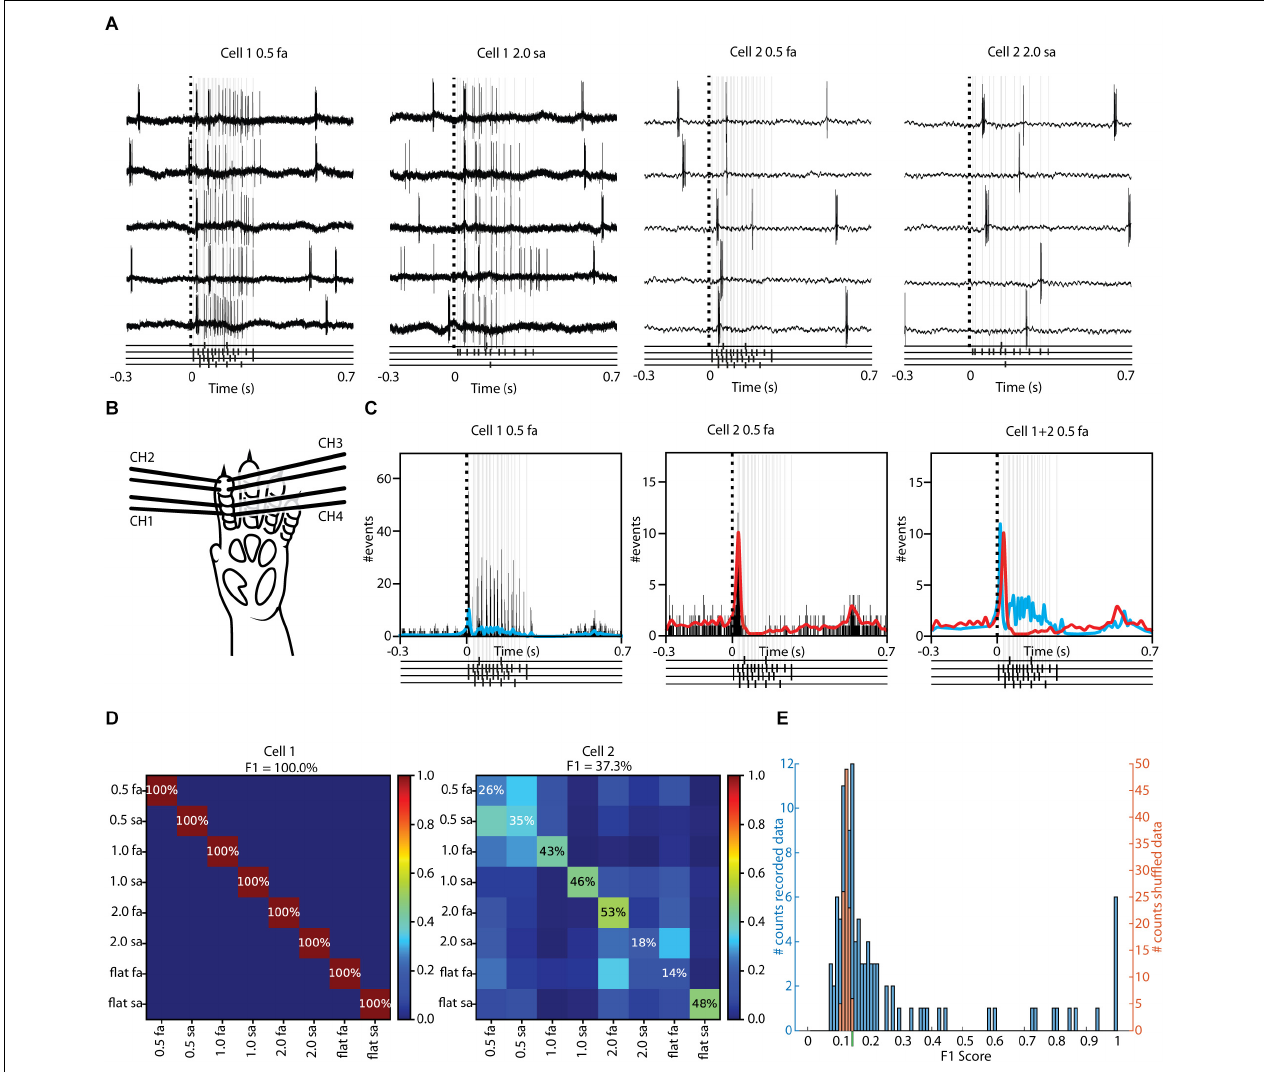
FIGURE 3 | A majority of our recorded thalamic neurons had above chance decoding of tactile input. (A) Sample raw responses of two different neurons to two different stimulation patterns. Below each sample, the presented stimulation pattern is shown with black markers with light gray lines extending upwards. (B) Schematic of the rat forepaw showing the location of the four pairs of electrotactile stimulation electrodes ( Supplementary Figure 1 illustrates the full set of stimulation patterns). (C) Peristimulus Time Histograms (PSTHs) and Kernel Density Estimations (KDEs) of all of the responses to one of the stimulation patterns for the two sample cells. The KDEs of the two cells are shown superimposed and normalized in the diagram to the right. Below each PSTH/KDE the presented stimulation pattern is shown with black markers with light gray lines extending upwards. (D) Confusion matrices of the decoding performance for the two sample cells across all eight stimulation patterns. (E) Decoding performance for the entire population of recorded neurons (blue bars). Orange bars show the corresponding distribution of the decoding following shuffling of the stimulation pattern labels. Green bar below the x -axis corresponds to the mean plus 2 SD of the shuffled data, which was the decision boundary for counting a thalamic neuron as being an above-chance decoder.